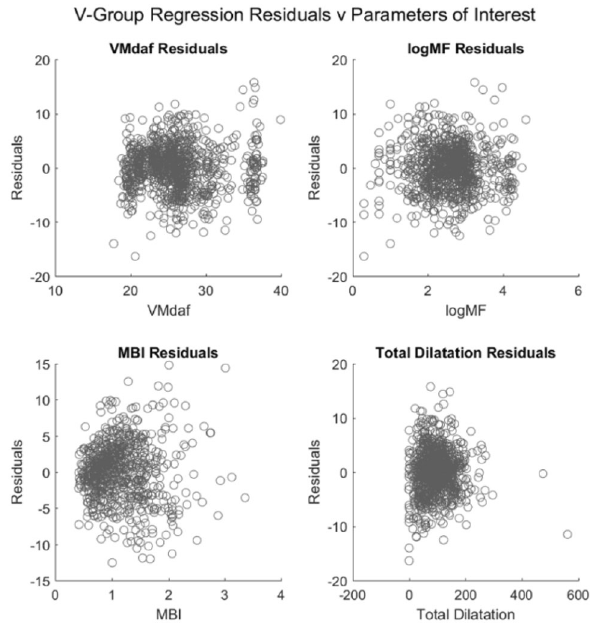
Fig. 10 V-group model residual plots of independent input variables VMdaf, logMF, and MBI, as well as parameter of interest total dilatation